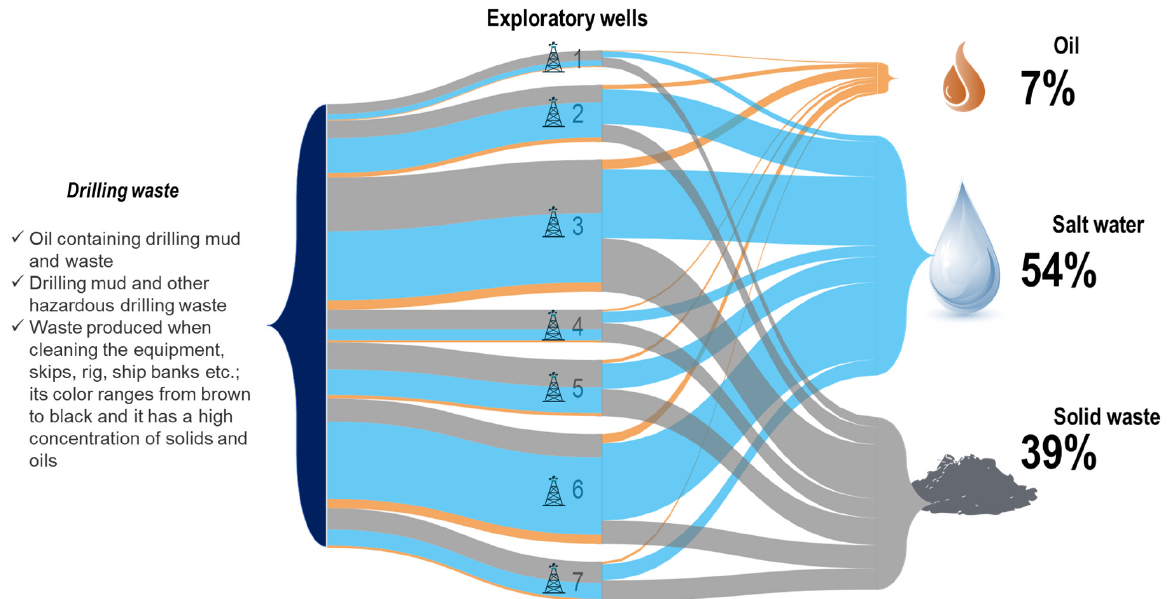
Figure 4. Valuable products obtained after thermomechanical cuttings cleaning at offshore exploration wells in Cyprus. Adapted from [8].